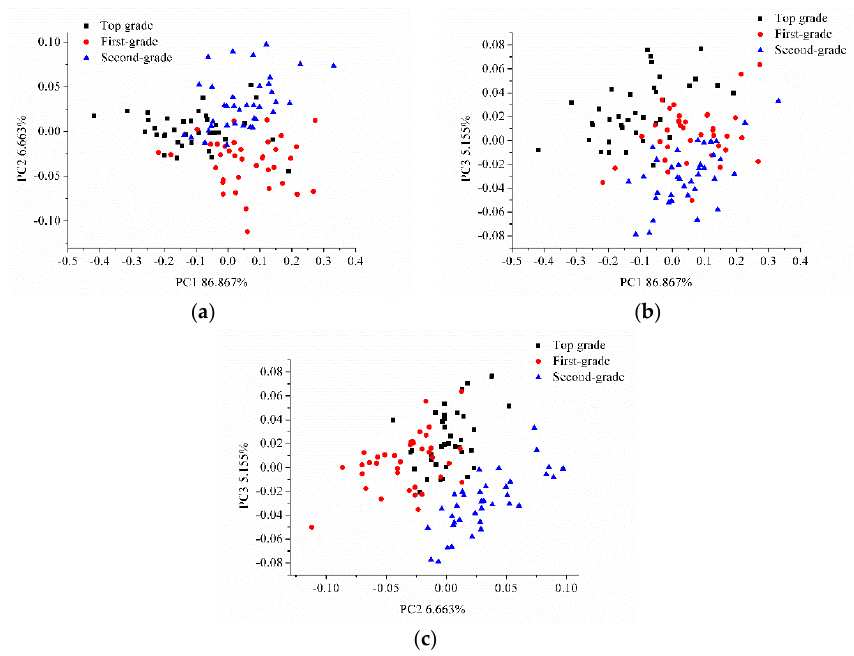
Figure 3. Score scatter plots of ( a ) PC1 vs. PC2, ( b ) PC1 vs. PC3, and ( c ) PC2 vs. PC3 for intact sausages.